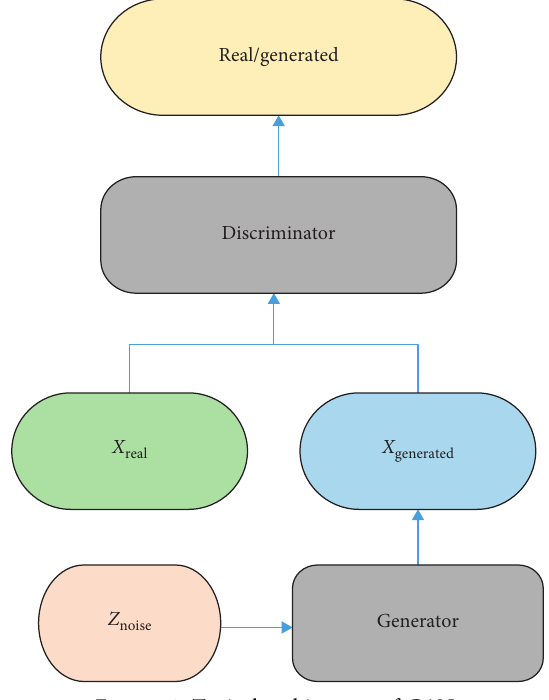
Figure 1: Typical architecture of